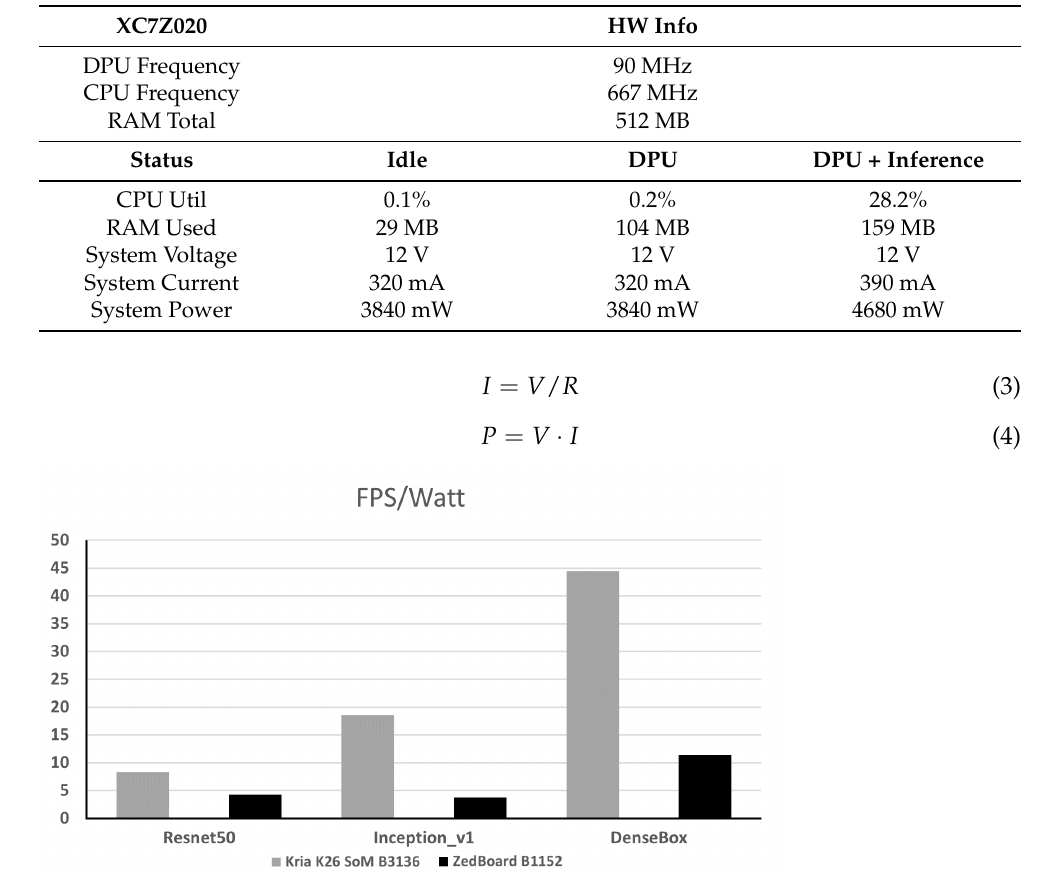
Table 4. Resource utilization on ZedBoard.